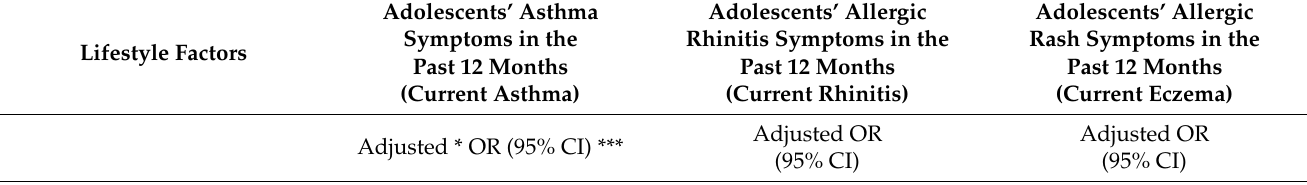
Table 4. Results from the multiple logistic regression analysis assessing the association between symptoms of an atopic disease (asthma, rhinitis, eczema) in the past 12 months and each of the studied lifestyle factors, adjusted for several confounders and the remaining lifestyle factors * ( n =